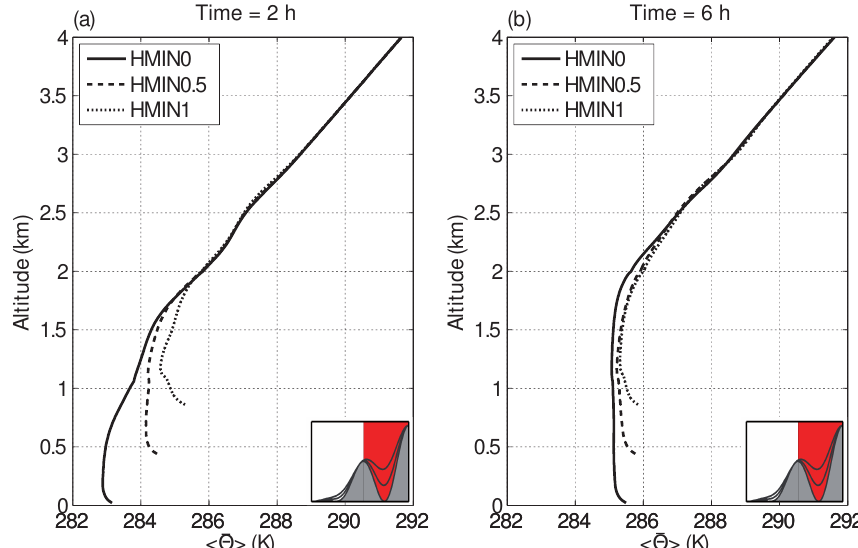
Figure 6. Mean vertical profiles of potential temperature after (a) 2h and (b) 6h of simulation for the mountain shapes HMIN0 (solid line), HMIN0.5 (dashed line), and HMIN1 (dotted line). The vertical profiles are vertically interpolated from model levels to constant height levels and horizontally averaged between the first and main ridge ( − 13 . 9 km ≤ x ≤ 0km, see red area in insets). Variables are averaged in time and space (along y direction) according to Eq. (5).